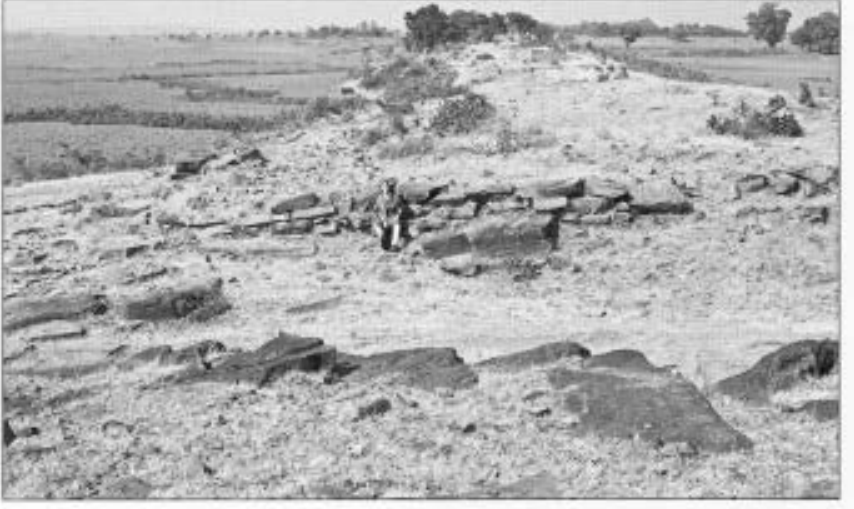
Figure 6 An ancient dam at Devrajpur, with spillway in